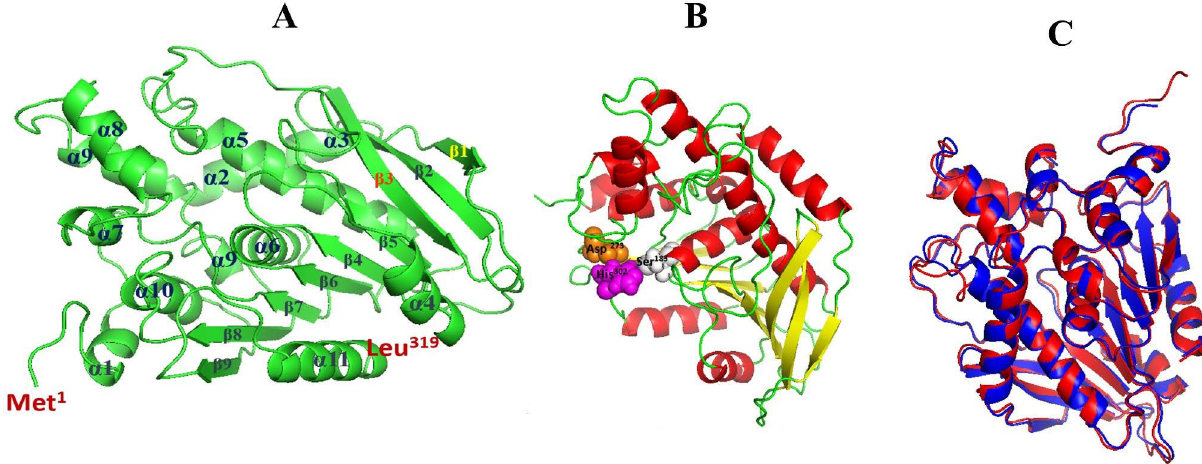
Fig. 7 A: Predicted 3D structure of AXE-HAS10 built up with the MODELLER of LMOETS3 program in cartoon view showing the α /β fold structure (9 β-sheets and 11 α–helices), antiparallel β1 and β3 sheets to the rest β-sheets, Met 1 (N-terminus), and Leu 319 (C-terminus). The view is for AXE-HAS10 in the monomeric state. B: Predicted 3D model in a cartoon view showing the catalytic triad at Ser 183 , Asp 273 , and His 302 . C: Superimposed cartoon view of the 3D backbones of AXE-HAS10 ( blue) and 6fkx_A PDB template ( red) with TM- score and RMSD value of 0.988 and 0.83, respectively